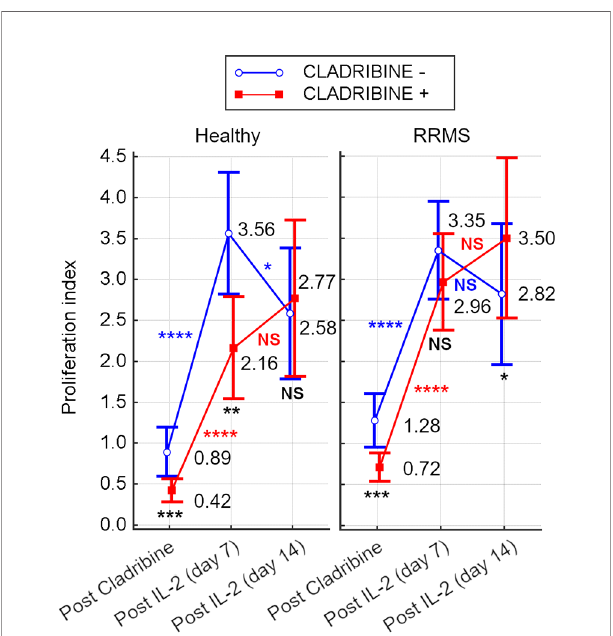
FIGURE 7 | Survival index of cells from HC and RRMS subjects after cladribine exposure and proliferation index after 7 days or 14 days of rh-IL2 activation in cultures. Signi fi cance levels are graphically presented as follows: NS, non signi fi cant (p>0.05), * p <0.05, ** p <0.01, *** p <0.001, **** p